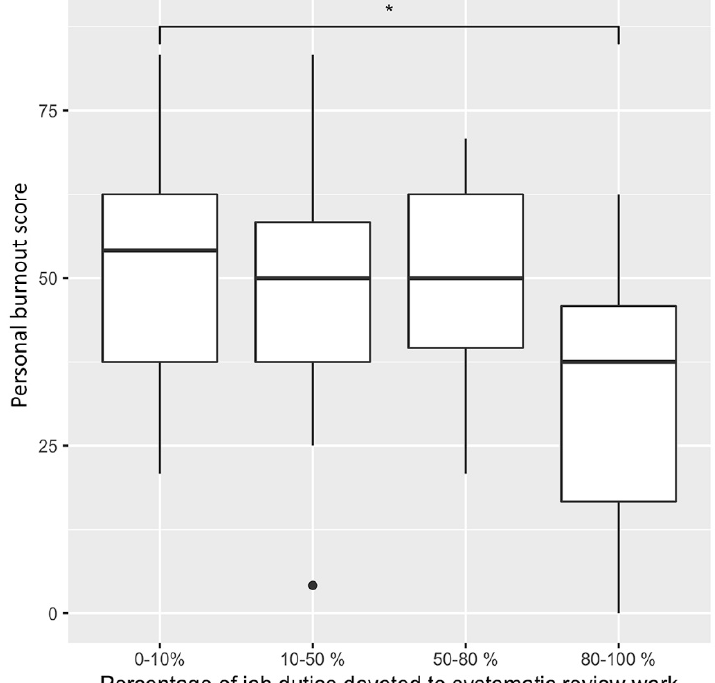
Figure 2 Personal burnout score depending on the percentage of job duties devoted to SR